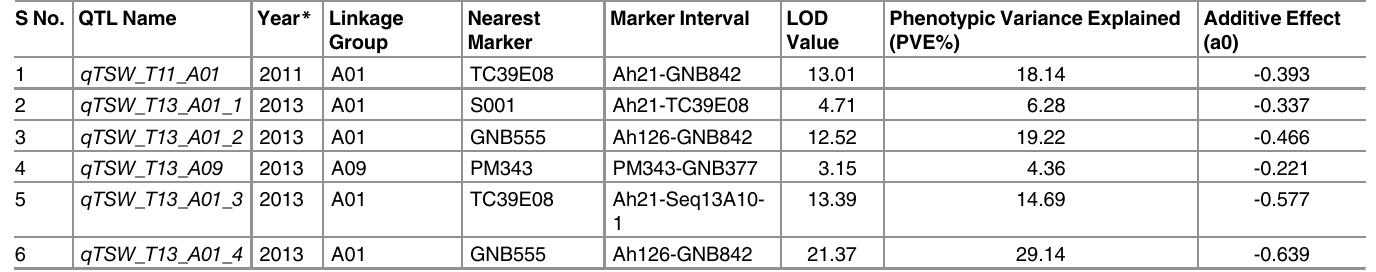
Table 4. QTLs identified for Tomato spotted wilt virus (TSWV) resistance in